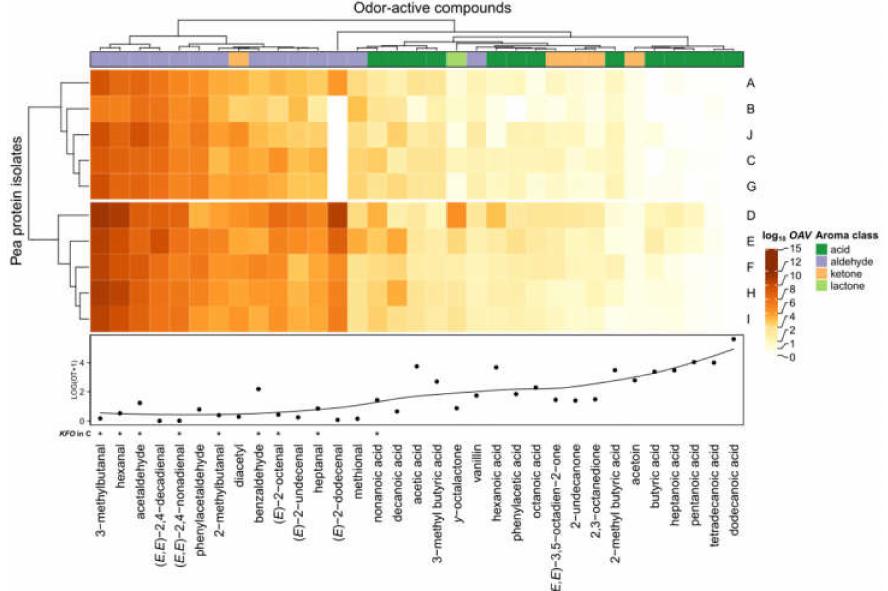
Figure 5. OAV mapping (heatmap) based on quantifiable odorants in different pea protein samples (A–J) and the corresponding odor thresholds (OT) determined in water. OAV data are log transformed. Asterisk (*) indicates KFO carried out with pea protein C by means of the Sensomics